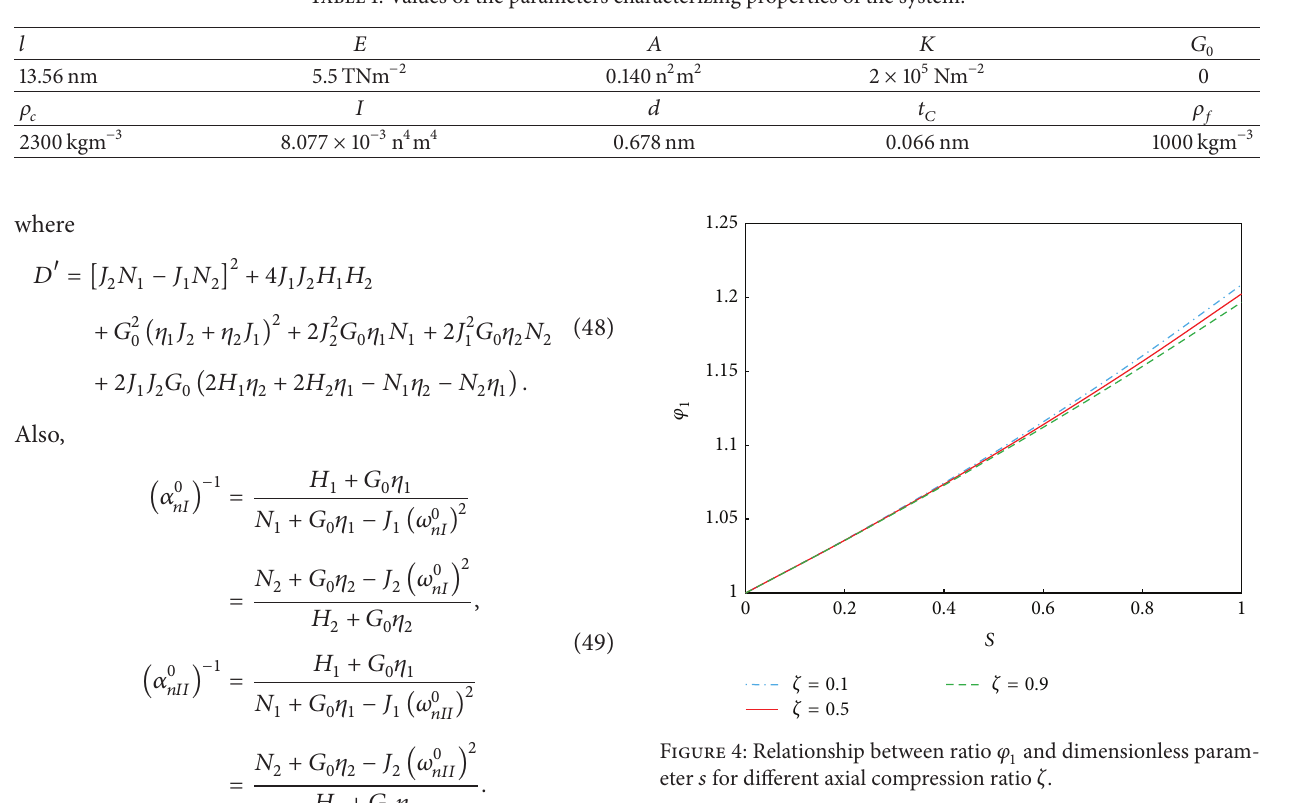
Table 1: Values of the parameters characterizing properties of the system.